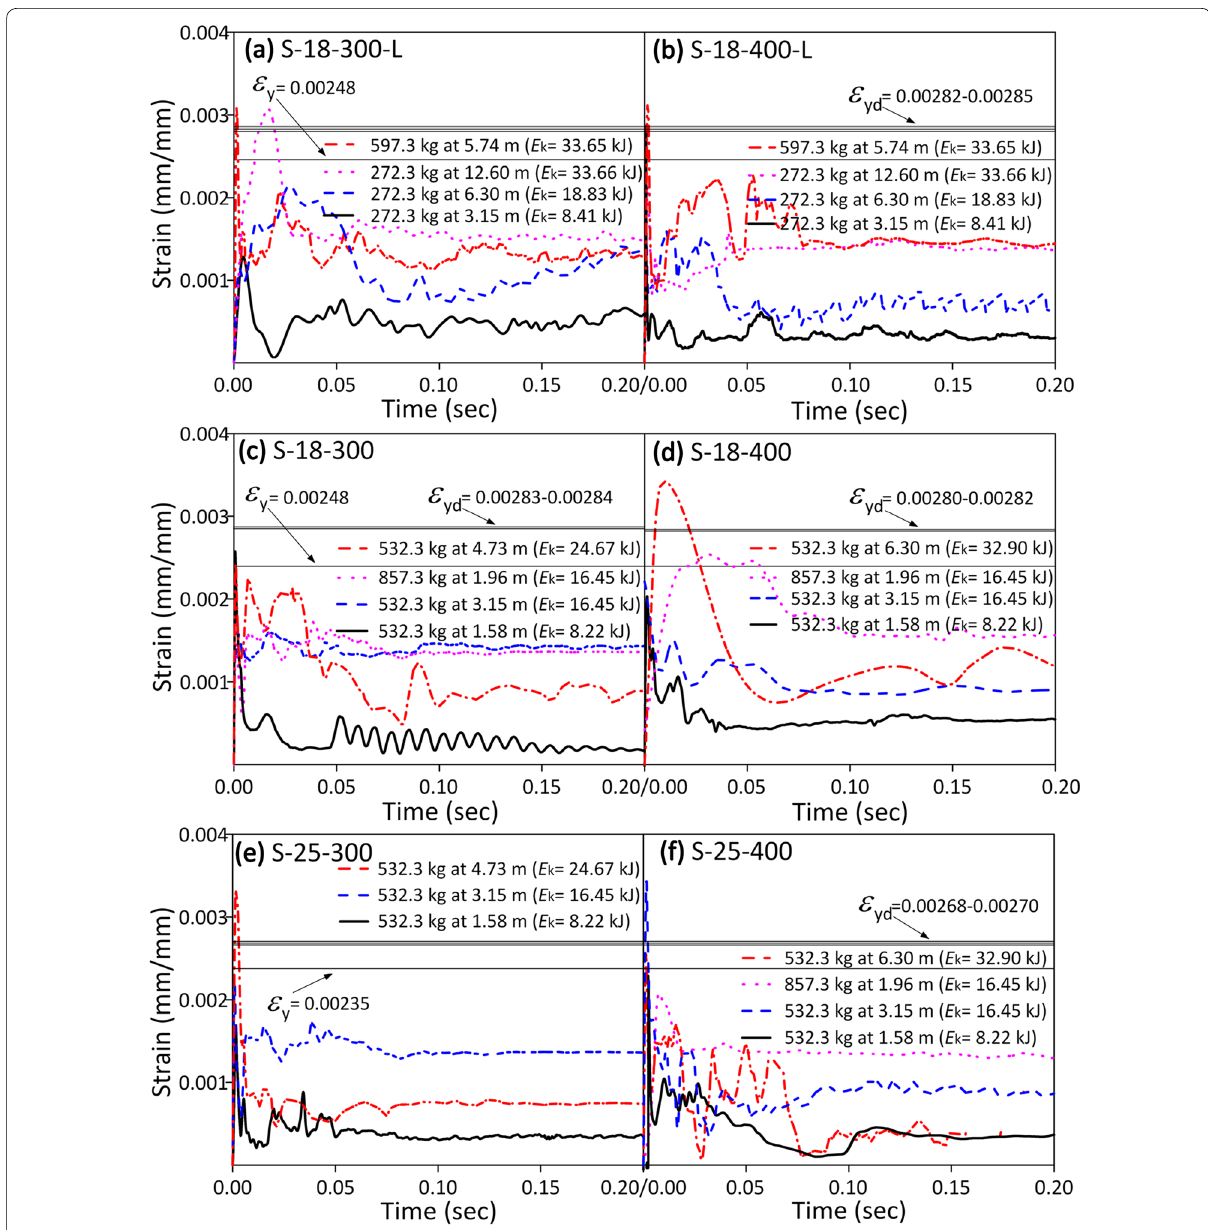
Fig. 7 Reinforcing bar strain